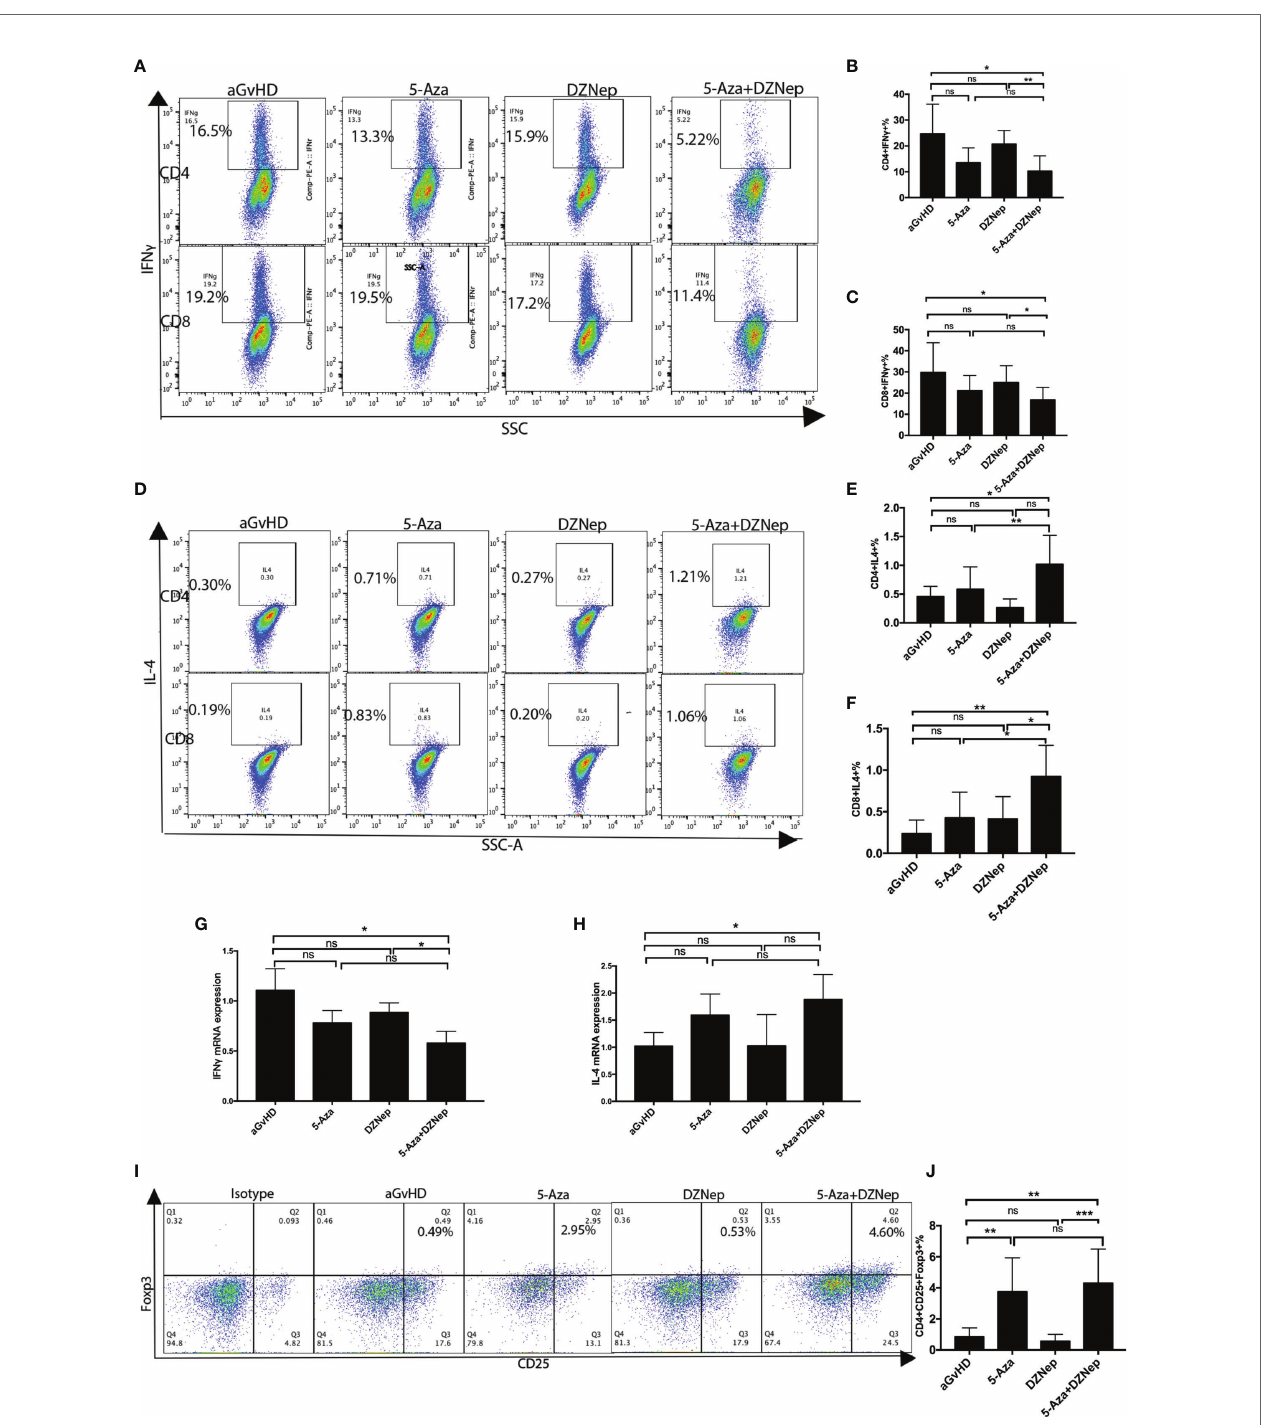
FIGURE 5 | Splenic T-celldifferentiation in each treatment group. (A) Representative fl ow cytometryresults of the proportionsof T helper type 1 (Th1) and T cytotoxictype 1 (Tc1) ineach group. (B, C) Statistical results of the proportionsof Th1 (B) andTc1 (C) ineach treatment group fromthree independent experiments. (D) Representative fl ow cytometry results of the proportionsof Th2and Tc2 in each group. (E, F) Statistical results of the proportionsof Th2 (E) and Tc2 (F) ineach treatment groupfromthree independent experiments. (G, H) qPCR results for the expressionsof splenicIFN g (G) and splenic IL4 (H) . (I) Representative fl ow cytometry results detecting the proportions of regulatoryT cells (Tregs) under the different treatment conditions. (J) Statistical results fromthree independentexperiments of the proportions of Tregs under the different treatment conditions. Statisticalresults wererepresentative of three independent experiments. Th1: CD4 + IFN g + cells; Tc1: CD8 + IFN g + cells; Th2: CD4 + IL4 + cells; Tc2: CD8 + IL4 + cells; Tregs: CD4 + CD25 + Foxp3 + . Each group contained 6 – 8 mice. *P < 0.05, **P < 0.01, ***P < 0.001, ns: P >